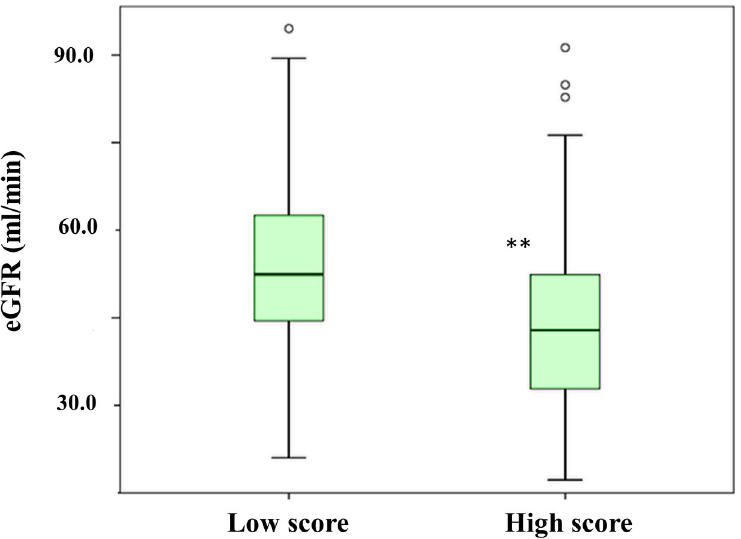
Fig 1. Distribution of estimated glomerular filtration rate (eGFR) values one year after grafting according to the score assigned to the pretransplant biopsies. �� p = 0.01.